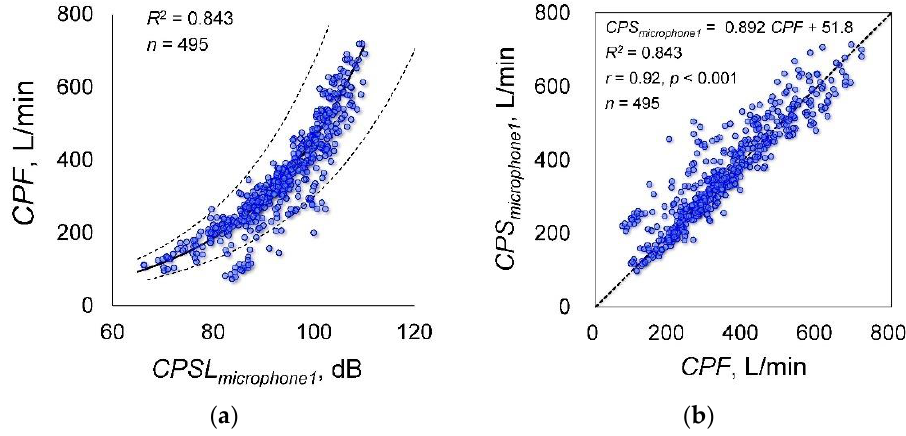
Figure 3. Estimation accuracy of Equation (7) calculated from the experimental data measured by microphone 1 attached to the flow sensor. ( a ) Relationship of CPF and CPSL microphone1 . The solid lines represent the regression curves derived by fitting the coefficients in the proposed model using the Levenberg-Marquardt method based on CPF and CPSL microphone1 . The dotted lines represent 95% confidence bands. CPF , cough peak flow; CPSL microphone1 , cough peak sound pressure level by microphone 1; ( b ) Relationship between CPF and CPS microphone1 . CPS microphone1 , estimated cough peak flow calculated from CPSL microphone1 .